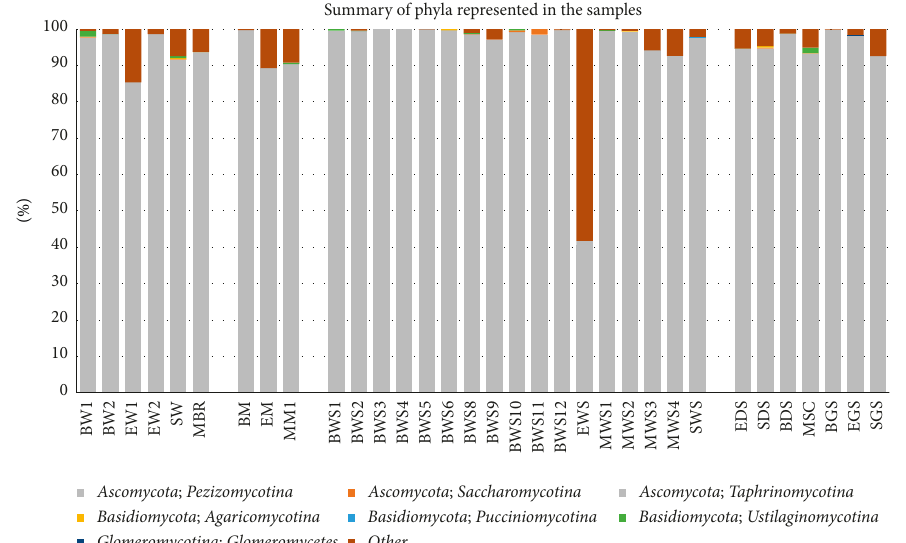
Figure 1: Distribution of OTUs at the class level across the 33 samples analyzed in this study. BW, EW, and SW denote water samples from Bogoria, Elmenteita, and Sonachi, respectively; BWS, EWS, MWS, and SWS denote wet sediment samples from Bogoria, Elmenteita, Magadi, and Sonachi, respectively; EDS and SDS denote dry sediments from Elmenteita and Sonachi, respectively; BM and EM denote microbial mats from Bogoria and Elmenteita, respectively, while MBR and MSC denote brine and salt crust from Magadi; BGS, EGS, and SGS denote grassland soils from Bogoria, Elmenteita, and Sonachi,